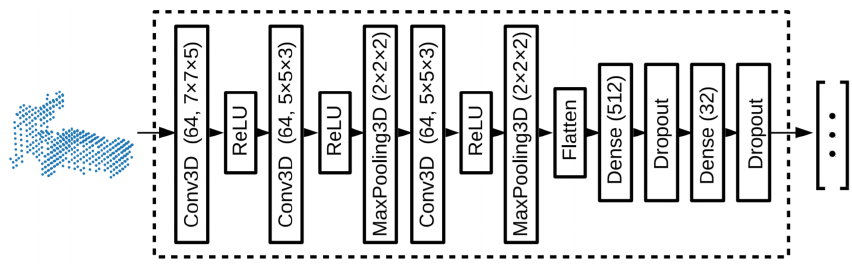
Figure 34. The descriptor extraction network [86] used in the three CNNs.